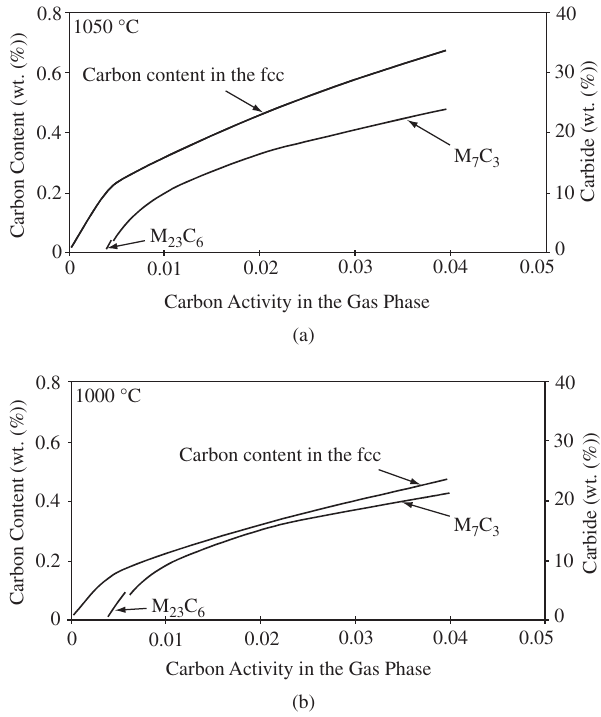
Figure 2. Thermodynamic equilibrium calculation at different temperatures using the commercial software FactSage: a) 1050 °C; and b) 1000 °C.